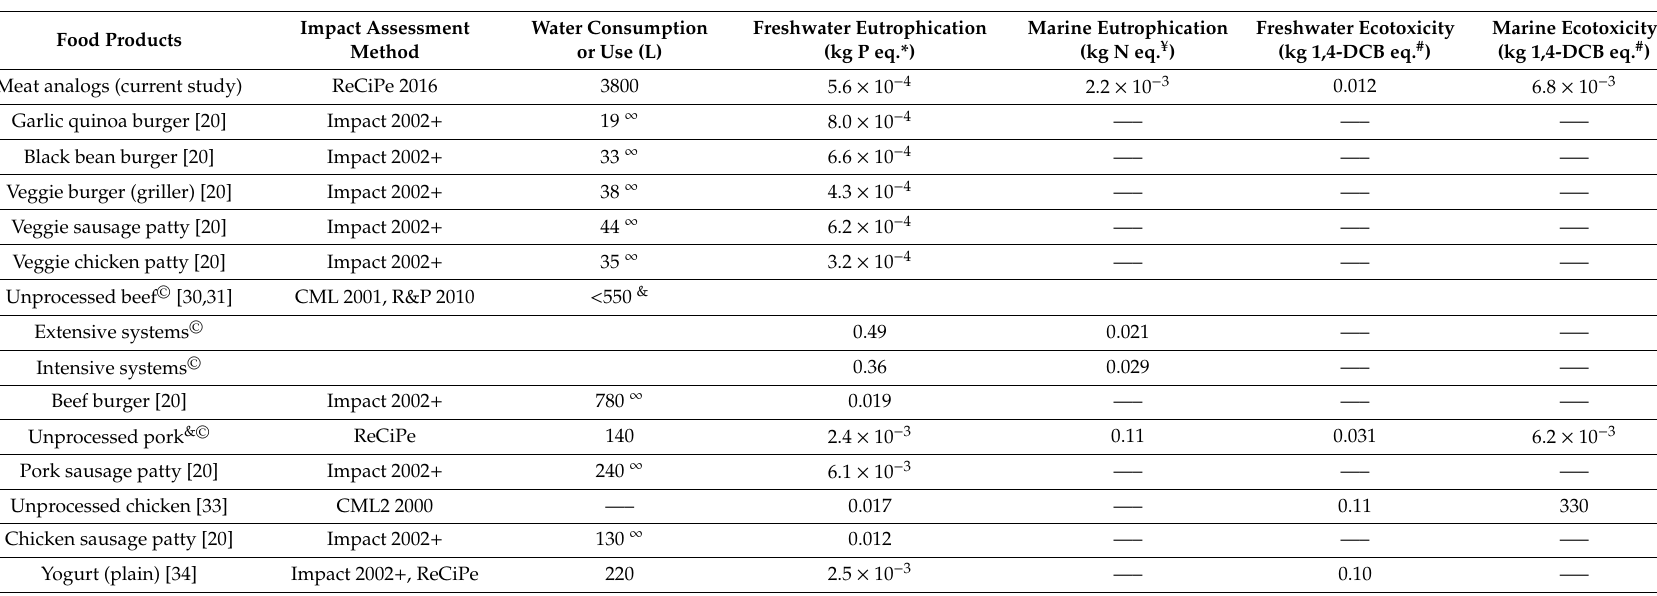
Table 3. Five life cycle assessment indicators associated with generating one kilogram (as the functional unit) of the products